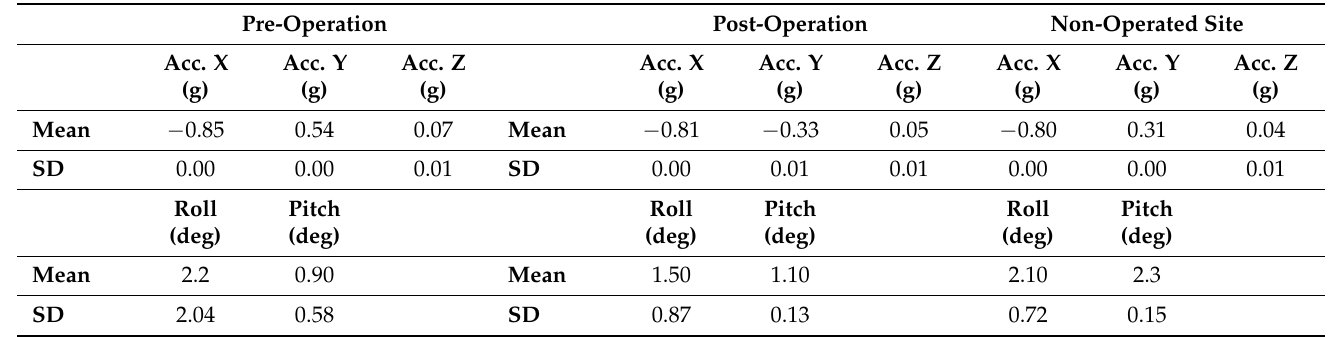
Table 1. A summary of numerical data from the test results in Figures 6 and 7. The boldness indicates the